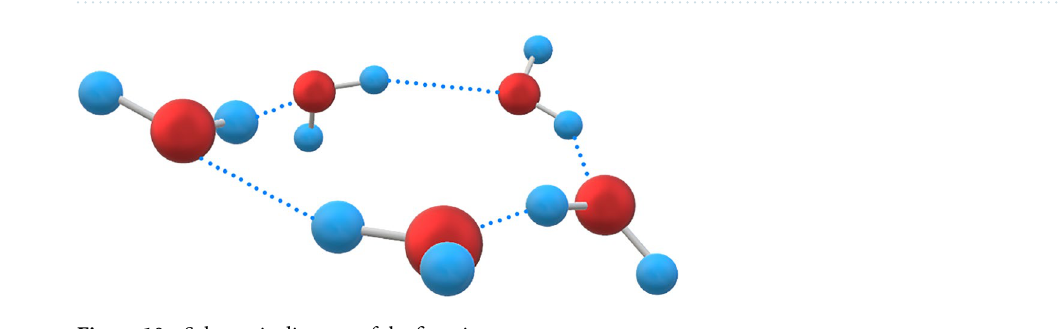
Figure 10. Schematic diagram of the five-ring water